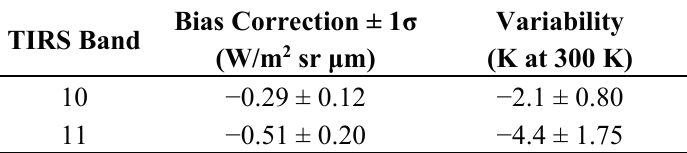
Table 3. TIRS Bias Correction, where the TIRS measurement was too hot, and the RMS variability in the bias, implemented in the USGS/EROS processing system on 2 February